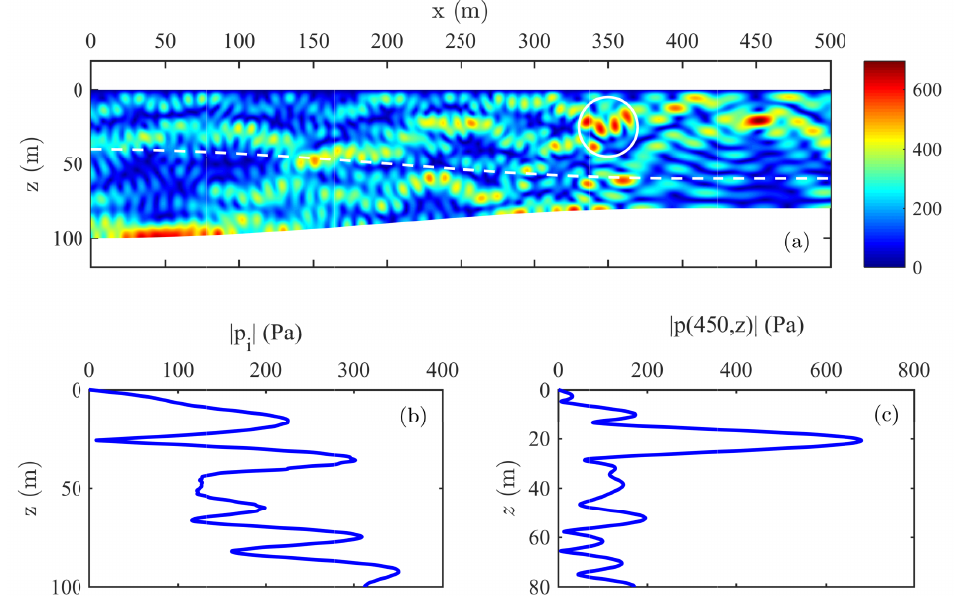
Figure 3. (Color online) Acoustic waves self-focusing in a two-layer range-dependent waveguide with a penetrable scatterer. The focus is at ( 450,20 ) m. ( a ) Sound field. ( b ) Acoustic pressure modulus of the optimal incident wave. ( c ) Acoustic pressure modulus along z -direction at x = 450